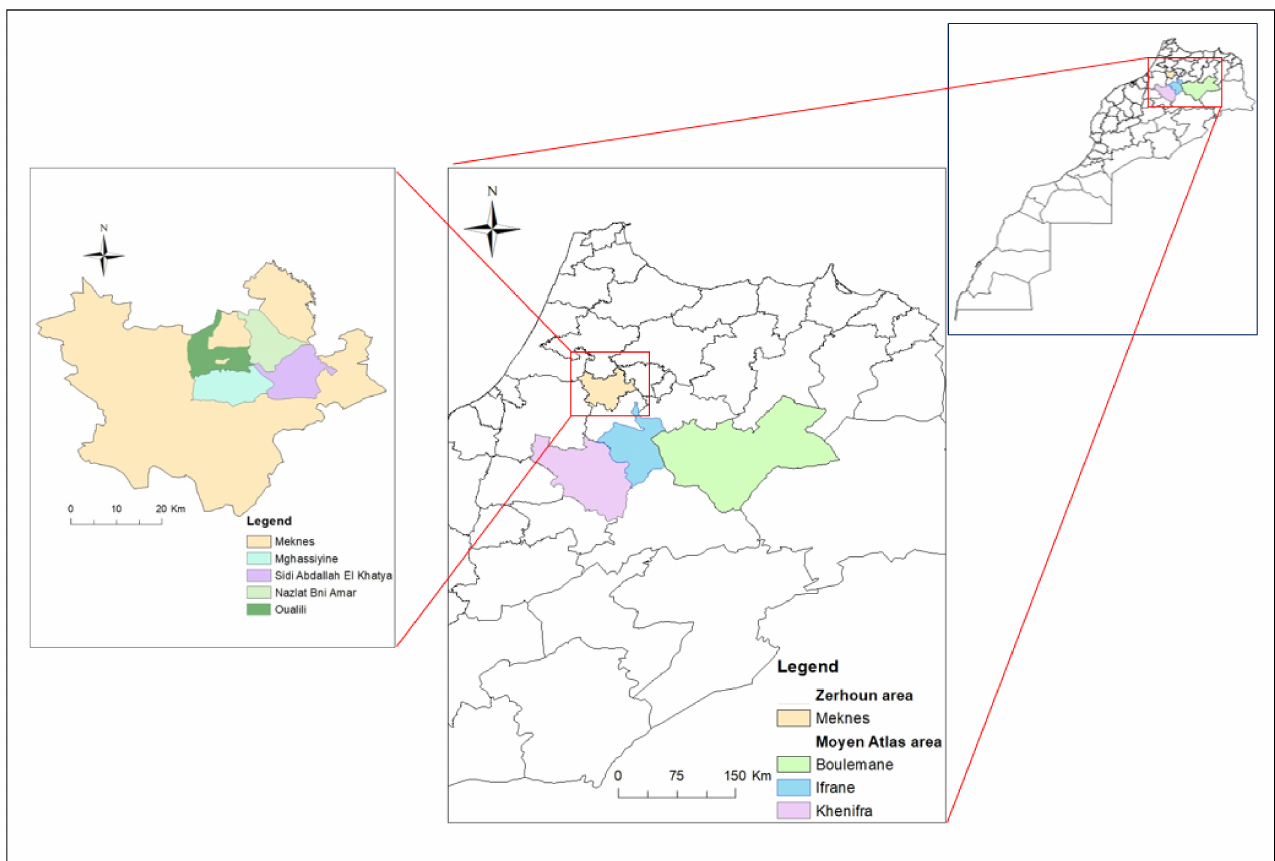
Figure 1. Geographical location of study areas Zerhoun (S1) and Middle Atlas